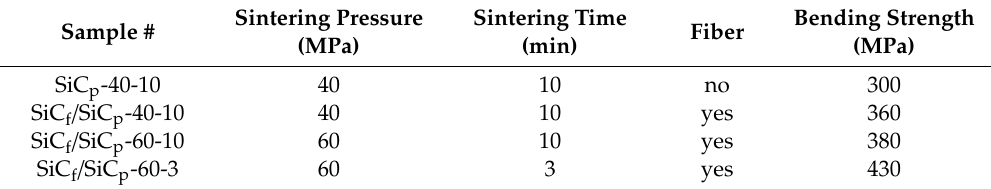
Table 2. Flexural strength of SiC f /SiC p composites and fiber-free SiC p ceramic.